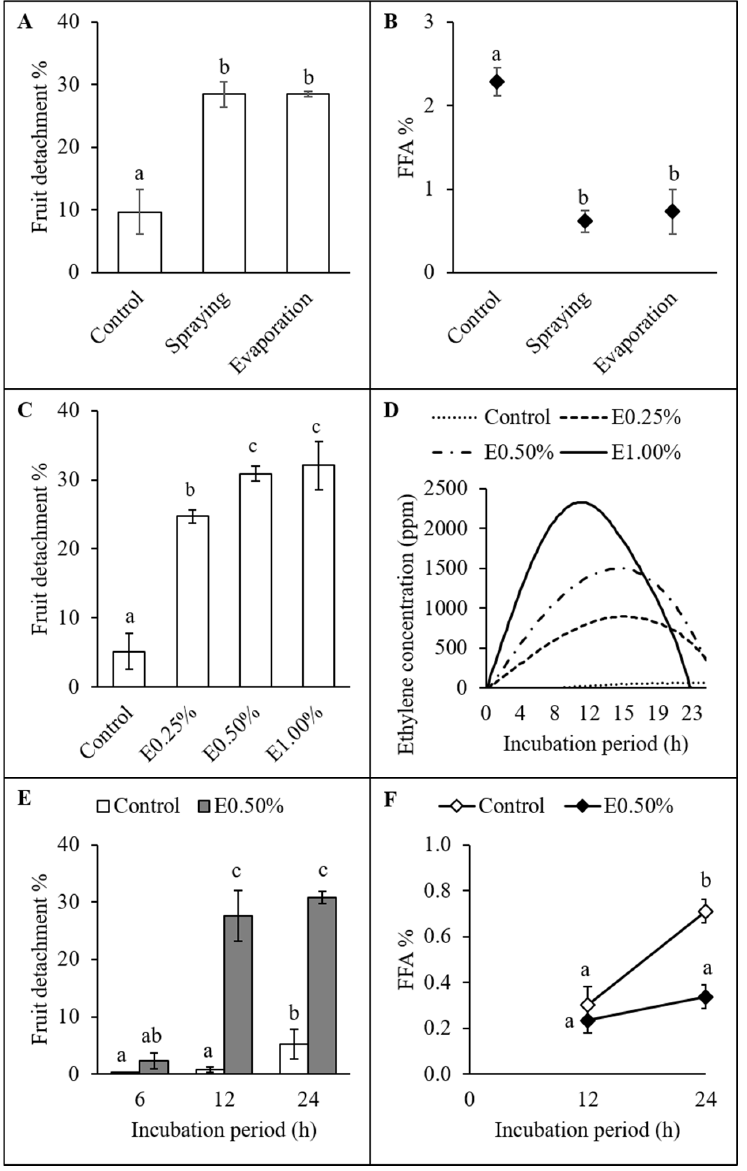
Figure 1. Detachment % and FFA level (%) in detached fruits after ethephon treatment by different application method, variable concentration and incubation period in oil palm bunches. Ethephon decomposition to ethylene gas (in ppm) was measured during the 24 h incubation period. ( A ) Fruit detachment (%); ( B ) FFA content, (%) after 0.50% ( v / v ) ethephon treatment for 24 h by spraying and evaporation methods; ( C ) Fruit detachment, (%) after 0.25% ( v / v ), 0.50% ( v / v ), and 1.00% ( v / v ) ethephon treatment for 24 h by evaporation method; ( D ) Decomposition of ethephon into ethylene measured at 2 h intervals for a period of 24 h; ( E ) Fruit detachment (%); ( F ) FFA content, (%) after 0.50% ( v / v ) ethephon treatment applied by evaporation method for 6 h, 12 h, and 24 h incubation periods. The data were presented as means of the replicates ( n = 5) and vertical bars indicate stand- ard deviation. Means that do not share a letter were significantly different at p < 0.05 according to Tukey’s range test. The effects of different incubation periods on fruit detachment and FFA content are shown in Figure 1E,F. The results reveal that the minimum incubation period needed to achieve the minimum fruit detachment at 27.6 ± 4.4%, was 12 h with 0.5% ( v / v ) ethephon. Although fruit detachment increased slightly to 30.8 ± 1.1% when the incubation period